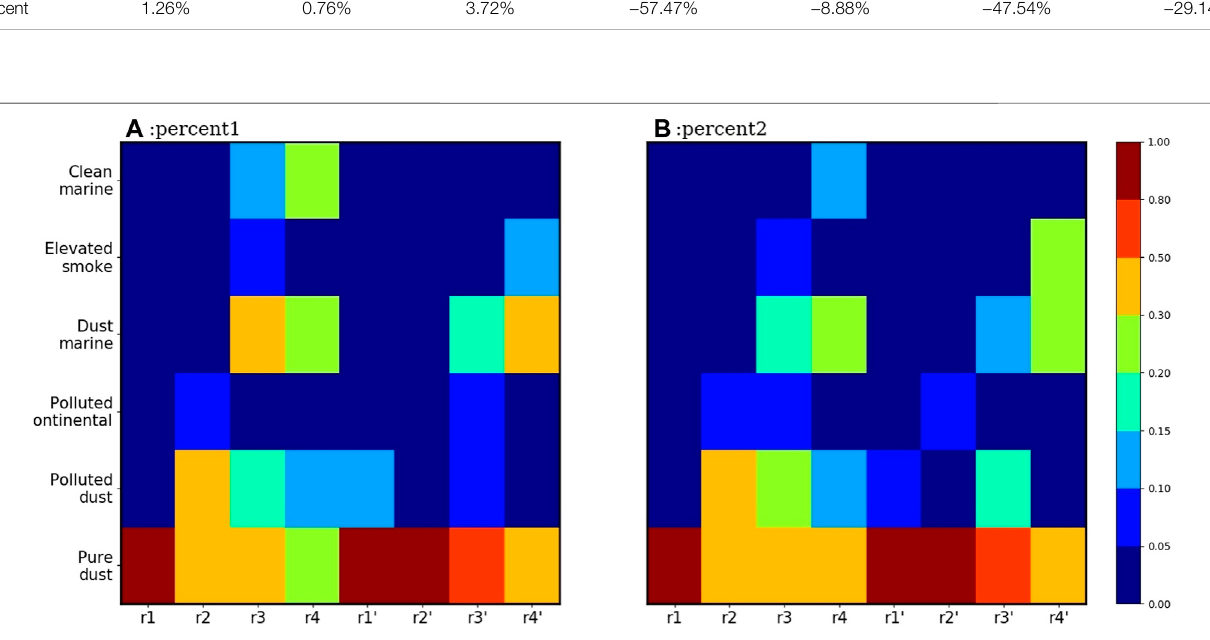
Frontiers in Environmental Science |